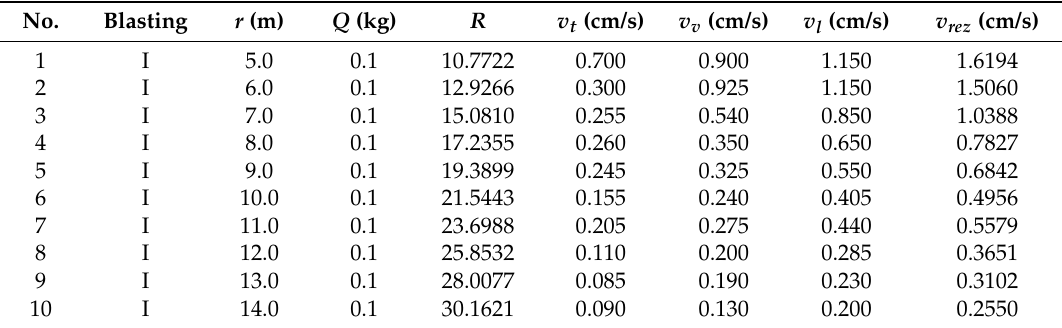
Table 1. Survey of blasting parameters and measurement results in Majdanpek open pit.